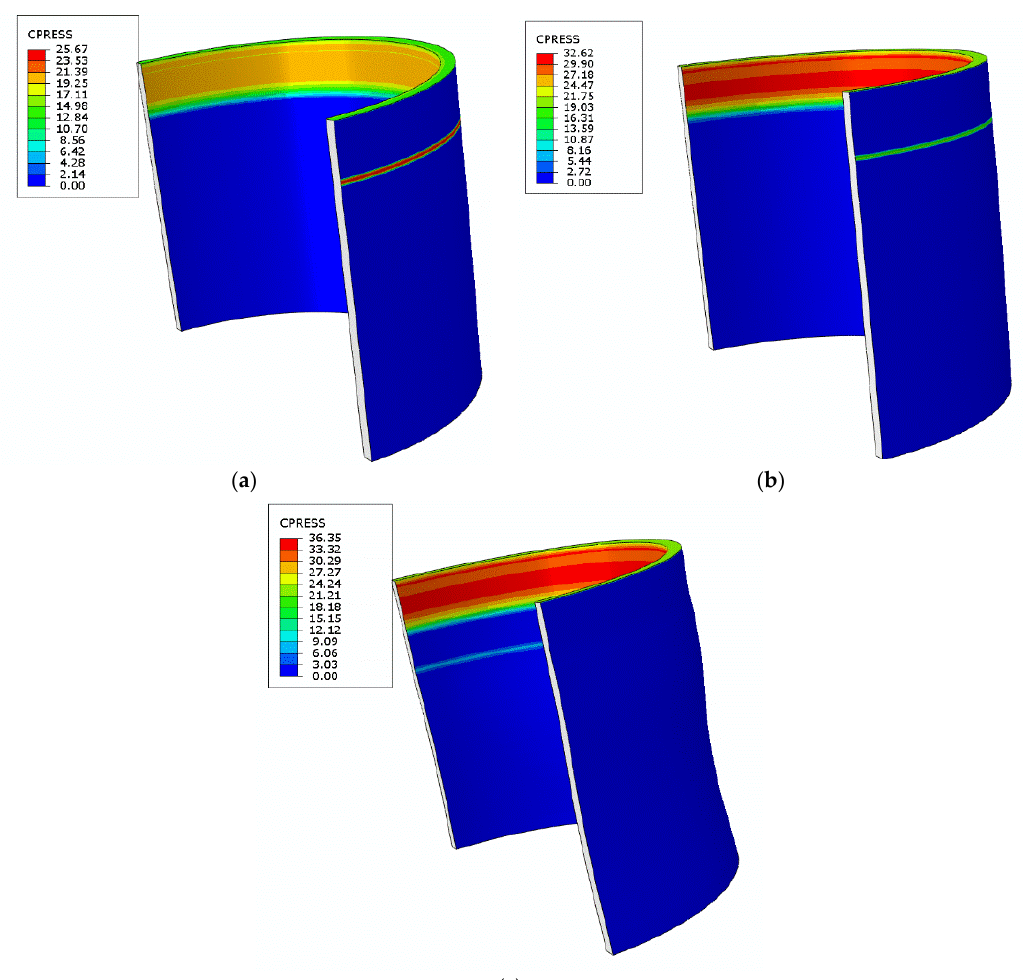
Figure 9. Contact pressure of polymeric sheath under different fluid pressures: ( a ) 20 MPa; ( b ) 30 MPa; ( c ) 40 MPa.